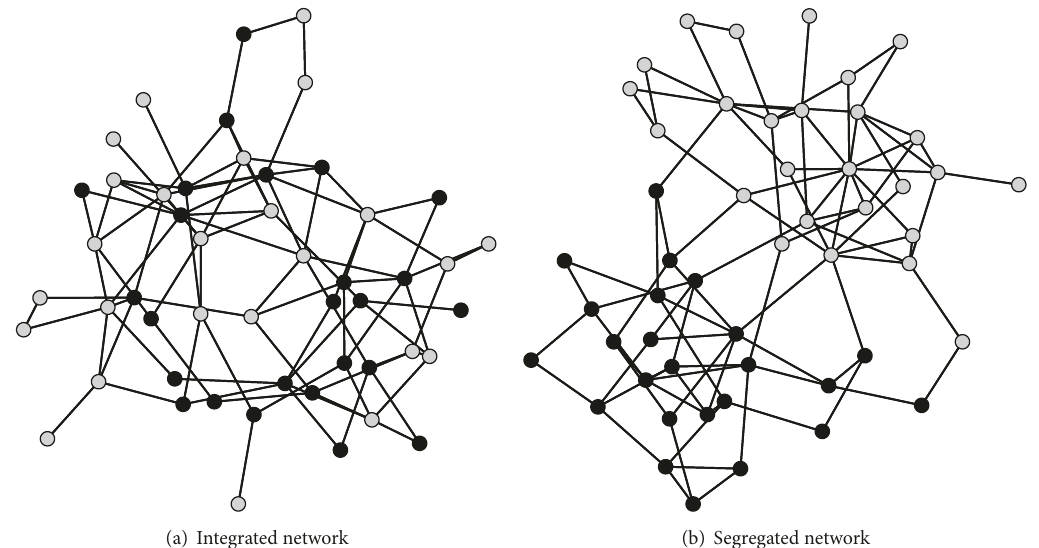
Figure 1: Illustrative network structures. Note: networks generated using ABMs of random network formation in R